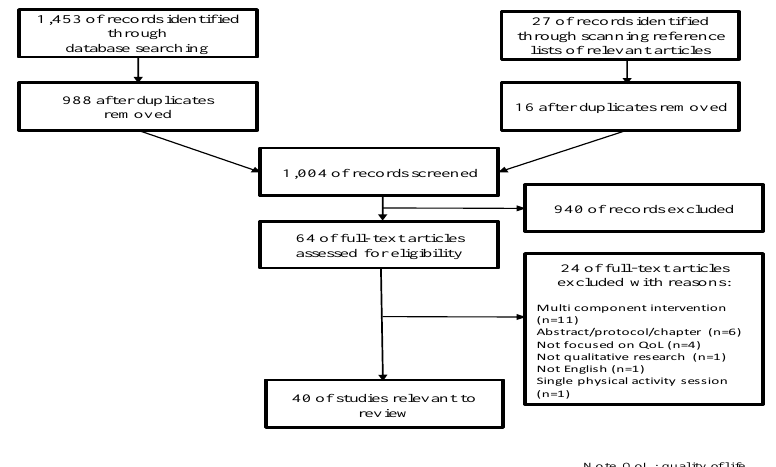
Figure 1. Flow diagram of studies identified, screened, and included in this meta-synthesis, along with reasons for